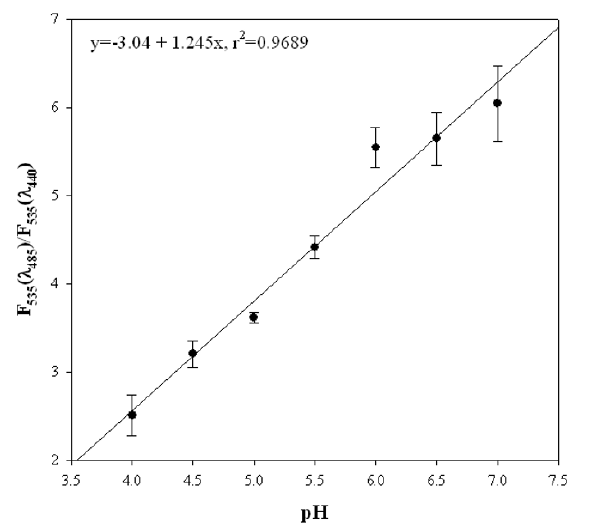
Figure 3 In vivo pH calibration curve of fluorescein-dextran (F 535 ( λ 485 )/F 535 ( λ 440 ) ratio against pH). Lysosomes of live J774A.1 cells were labeled with fluorescein-dextran and then incubated with MES calibration buffer solutions (pH from 4.0 to 7.0) containing nigericin and monensin. Fluores- cence images of emission wavelength at 515–565 nm were acquired under the excitation at 485 and 440 nm (i.e. F 535 ( λ 485 ) and F 535 ( λ 440 ), respectively). The ratio of F 535 ( λ 485 ) over F 535 ( λ 440 ) in the lysosomes was then calcu- lated as described in the Methods section.